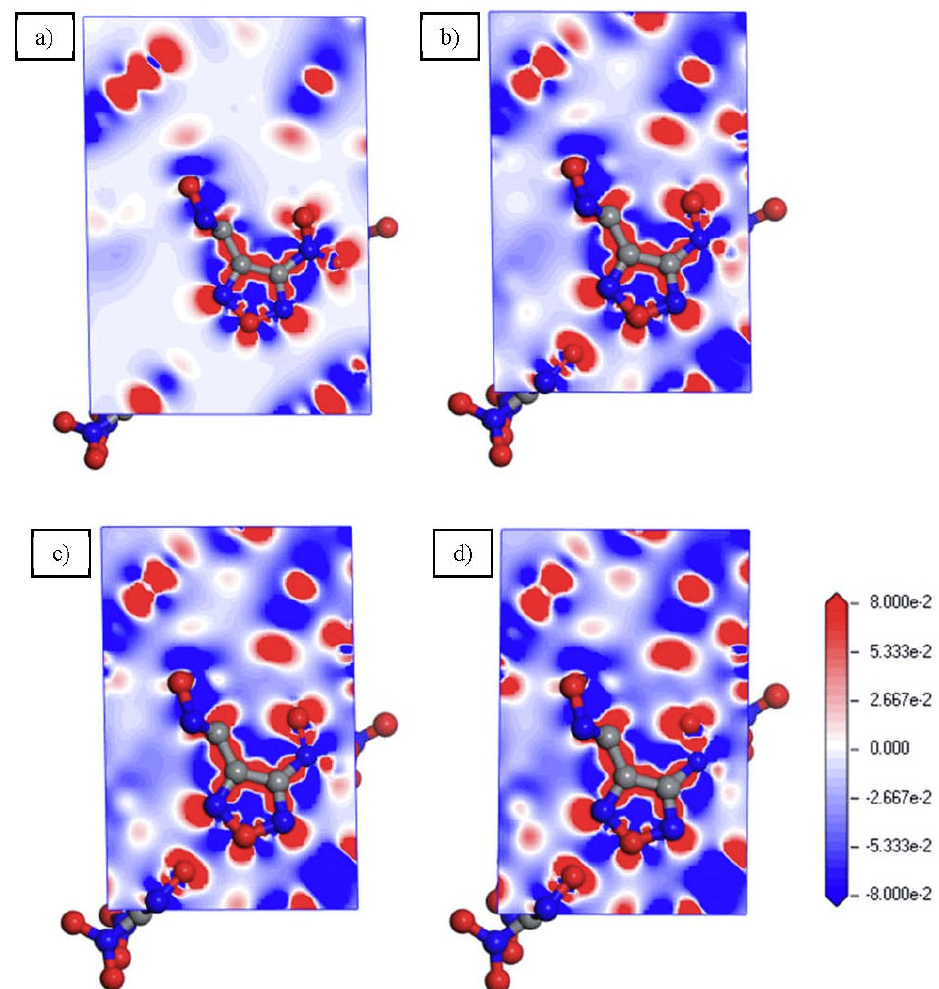
Figure 9. The electron density difference of DNTF under different pressure. ( a ) 0 GPa; ( b ) 20 GPa; ( c ) 40 GPa; ( d ) 60 GPa.